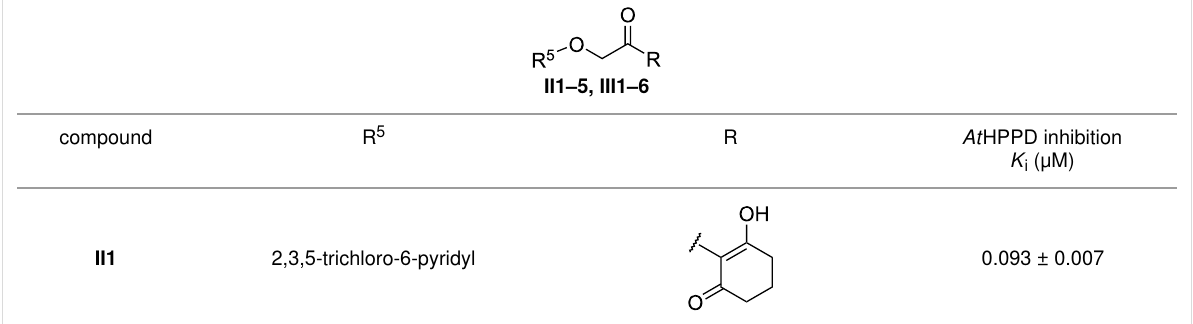
Table 2: Chemical structures of title compound II , III and their biological activity against At